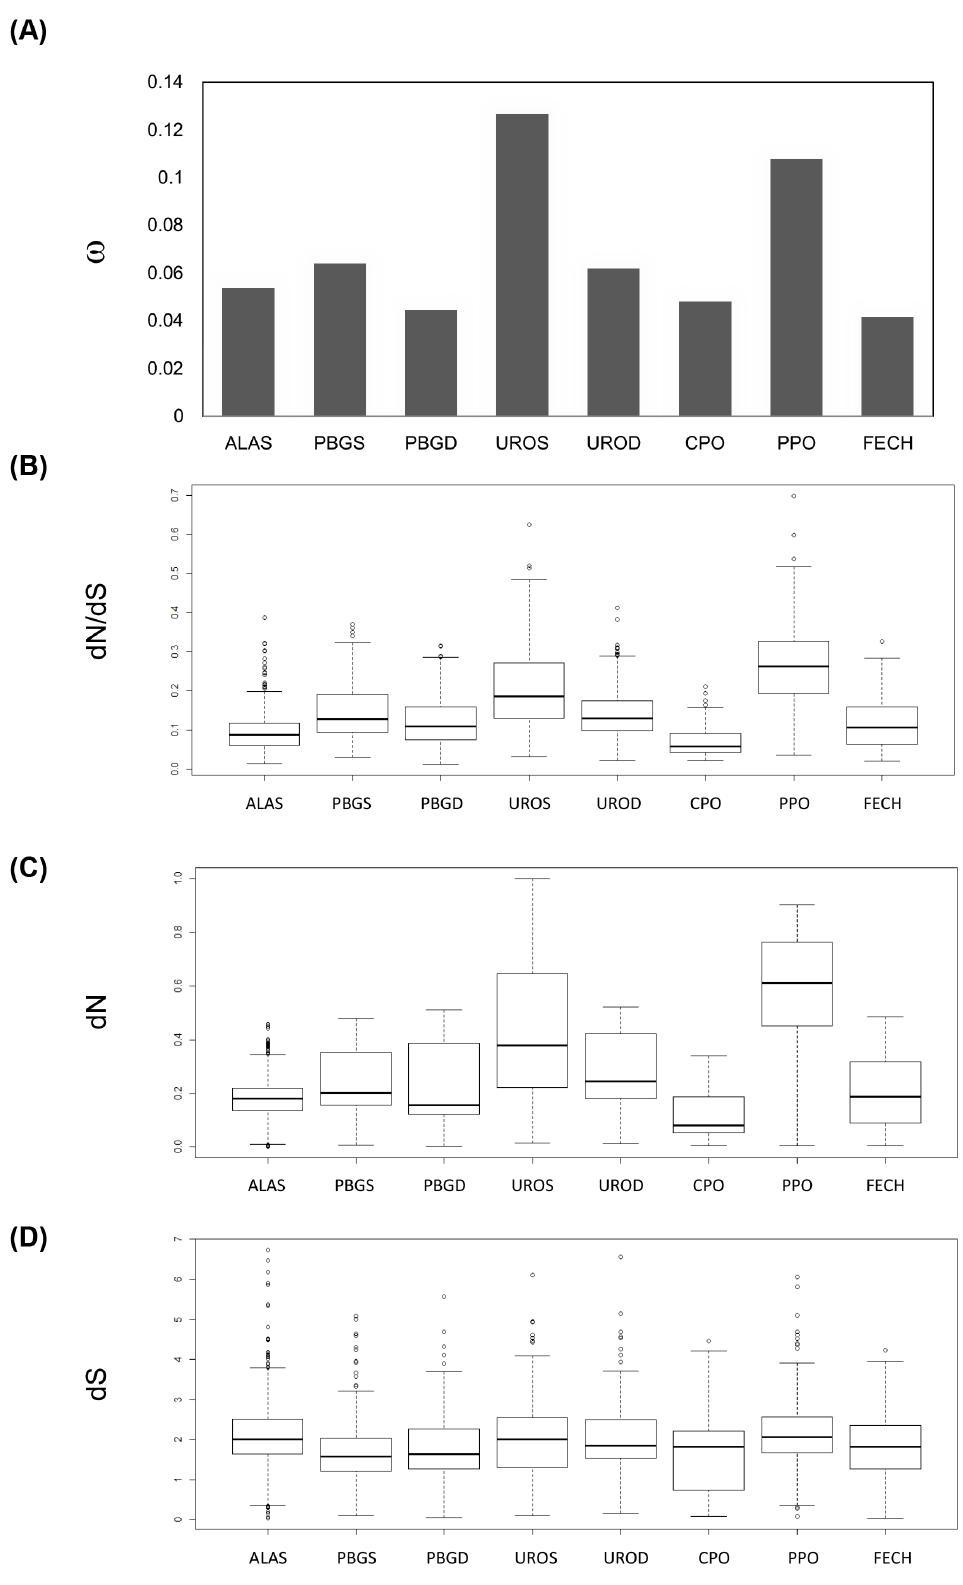
Figure 2. Selection pressure on heme biosynthesis genes in animals. v values ( d N /d S ) were estimated with the M0 model for the eight heme biosynthesis genes in animals (A). The distribution of v values (B), the nonsynonymous substitution rate, d N (C), and the synonymous substitution rate, d S (D). The order of genes follows the linear order of their pathway positions (Figure 1).